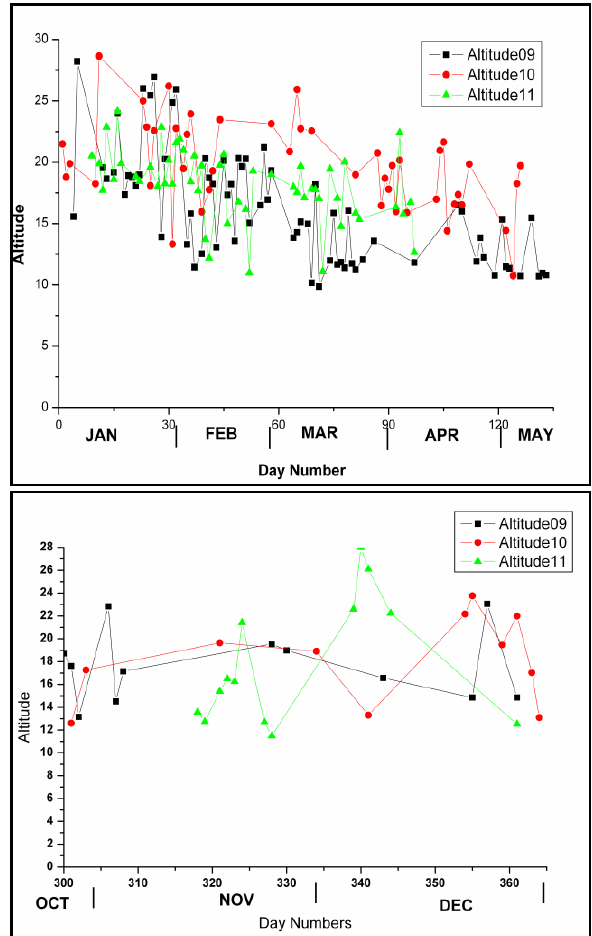
Figure-5: Three years annual variations for altitudes of Junge layer peaks